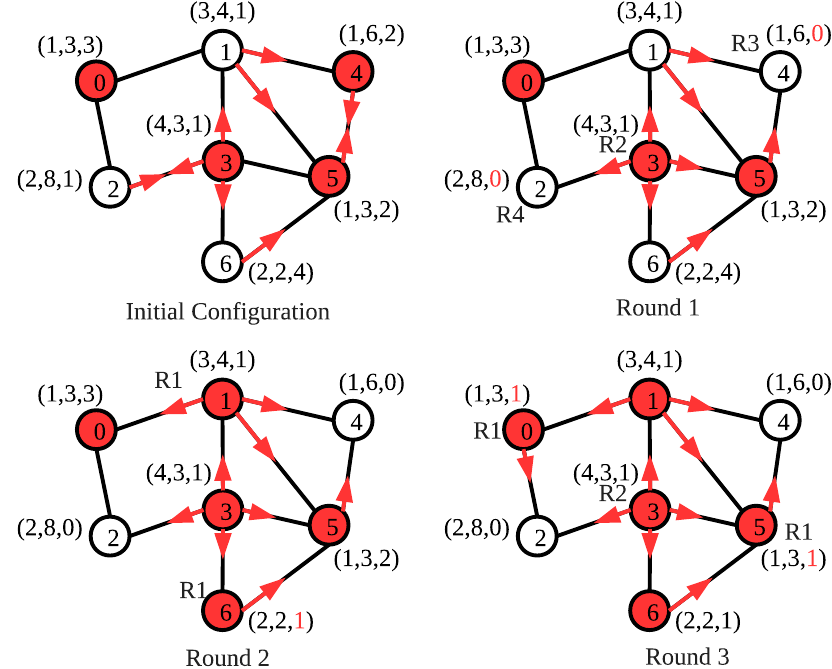
Figure 5. An execution of the SS-CVC 2